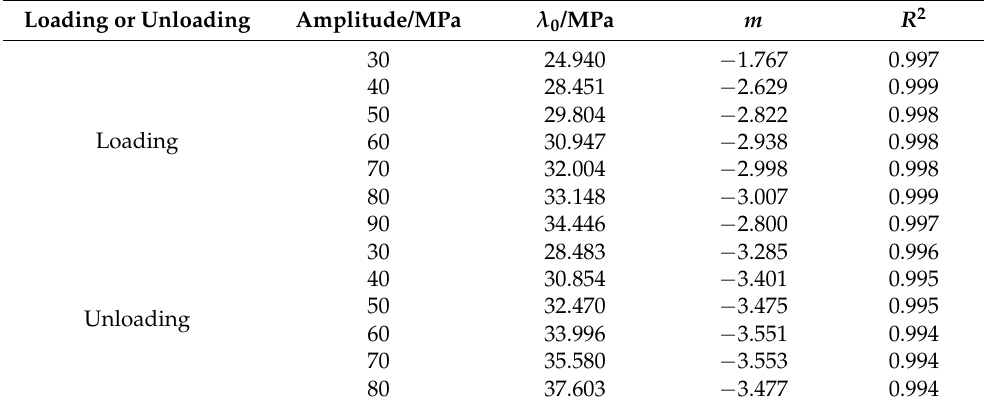
Figure 11. Experimental curve fitting of whole-stage cyclic loading process.